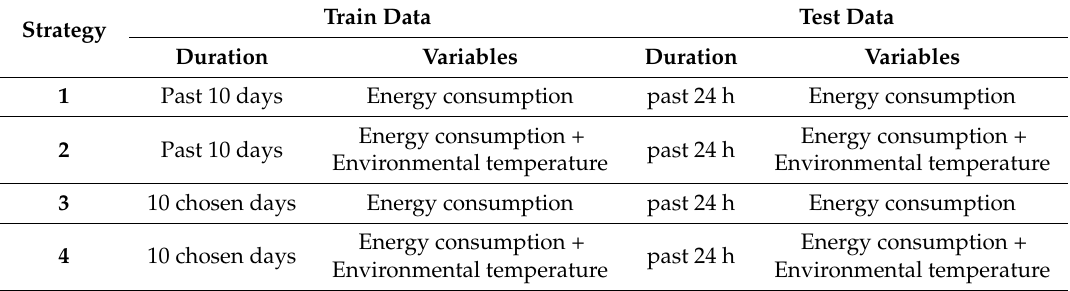
Table 1. Used data sets in the proposed strategies of this